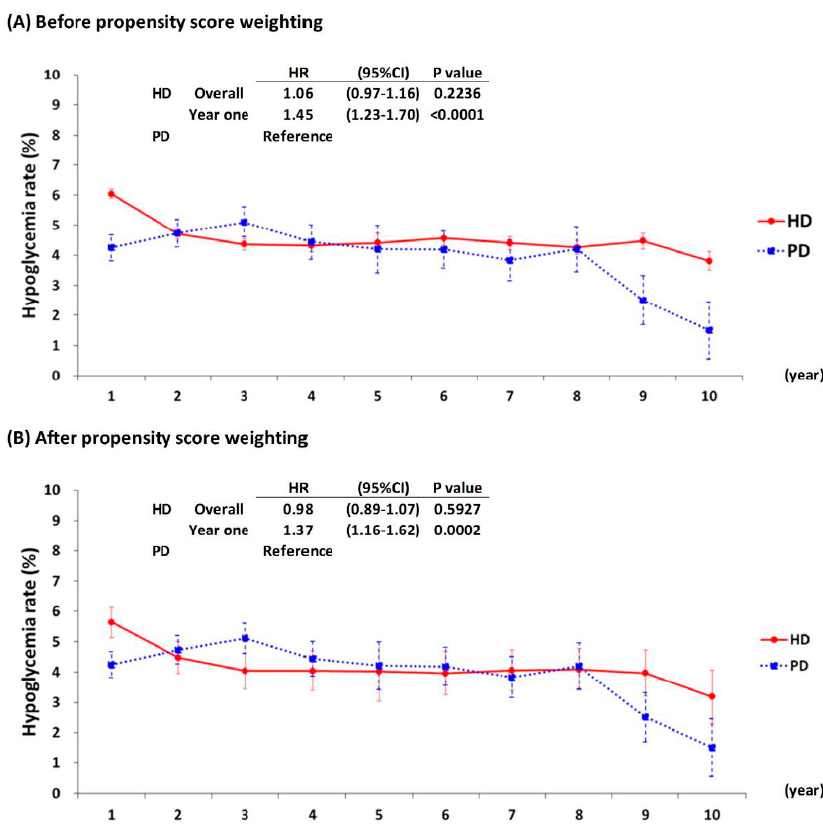
Figure 3. Severe hypoglycemic rates after dialysis among diabetic kidney patients.